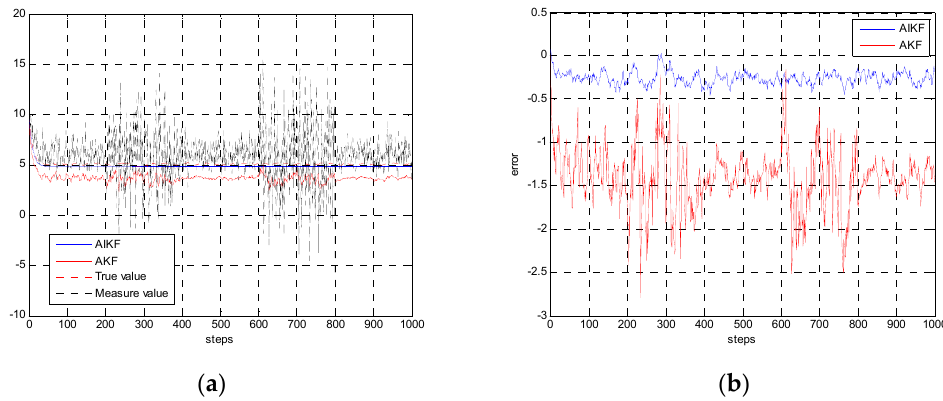
Figure 2. Comparison of AKF and AIKF. ( a ) Estimation result of AIKF and AKF; ( b ) Estimation error of AIKF and AKF.